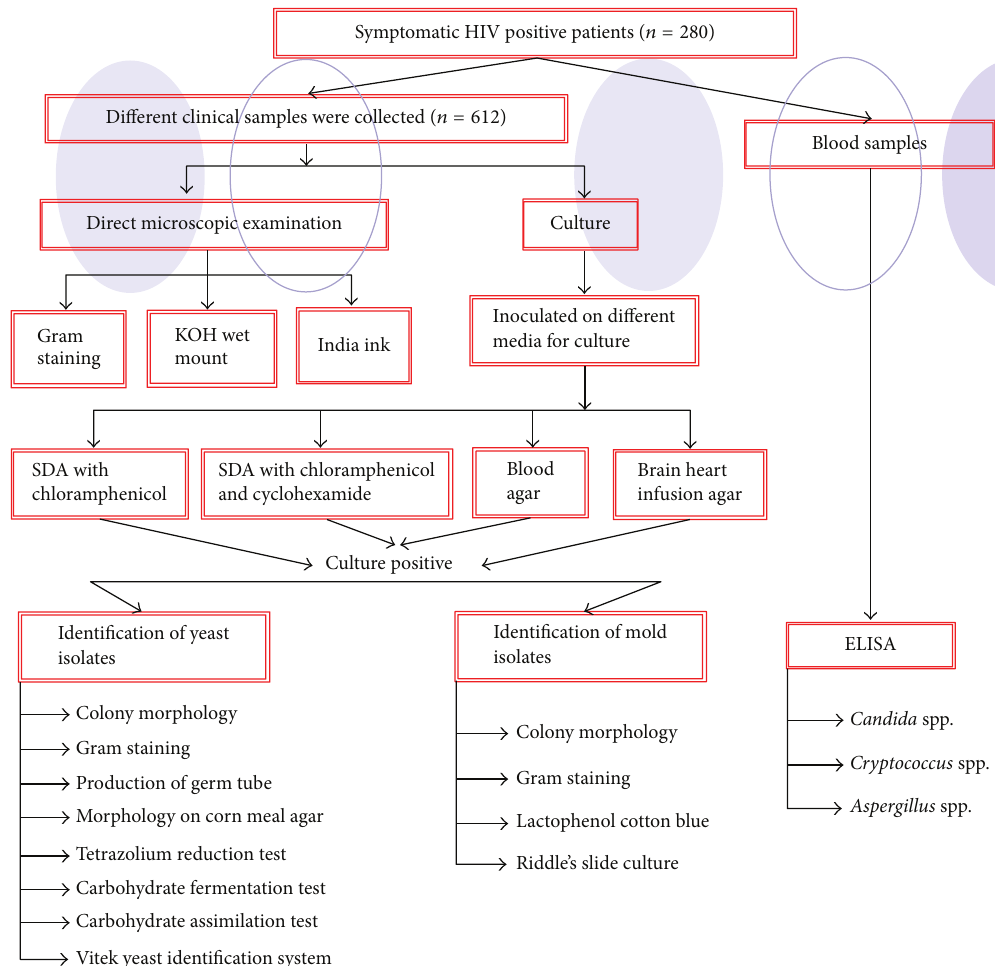
Figure 1: Flowchart of the